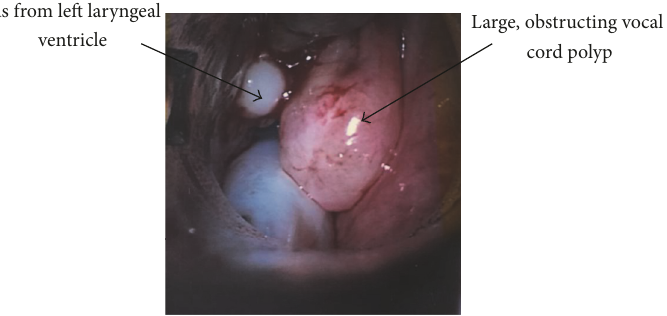
Figure 1: Intraoperative image demonstrating pus from left laryngeal